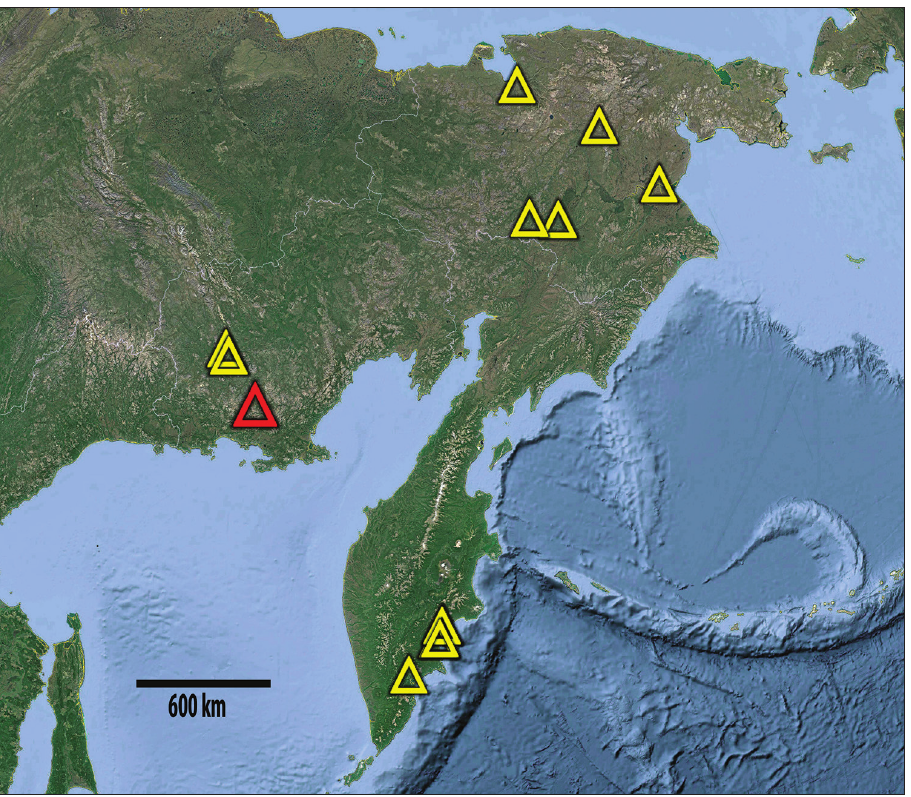
Figure 29. Distribution of Lithobius ( Chinobius ) yuchernovi sp. n. The type locality is shown in